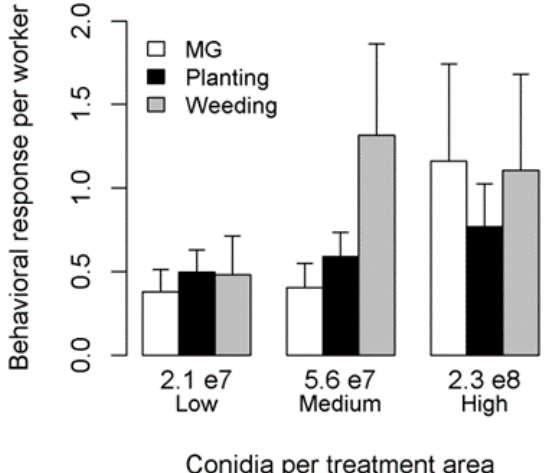
Figure 1. Ant workers’ behavioral response when exposed to three different Metarhizium brunneum conidia amounts. Error bars represent standard errors.